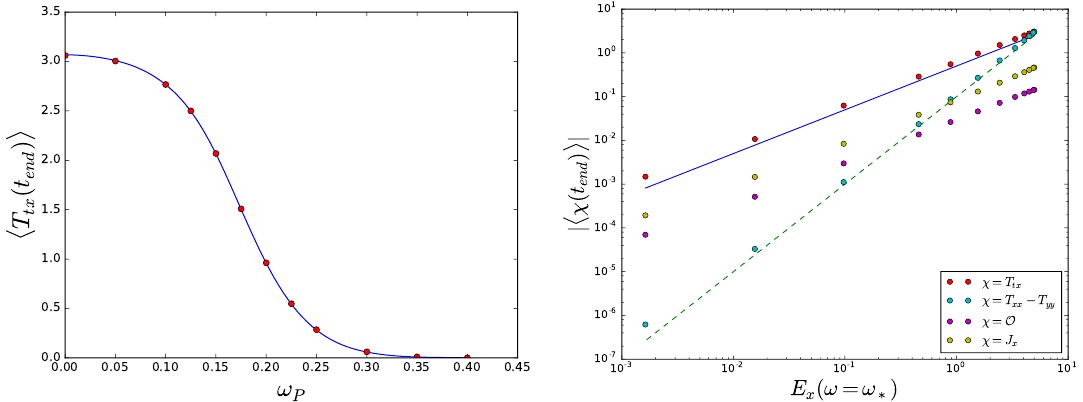
Figure 9 . Left: the red dots are data points obtained from the full numerical solution. The blue curve is a (cid:12)t to the functional form (4.27) with a single (cid:12)tting parameter (the overall scale). The root-mean-square error of the (cid:12)t is RMSE (cid:25) 0 : 0036. Right: di(cid:11)erent one point functions evaluated at t = t end plotted as functions of the Fourier transformed electric (cid:12)eld (4.27). The blue solid line corresponds to a linear relation, while the green dashed line corresponds to a quadratic